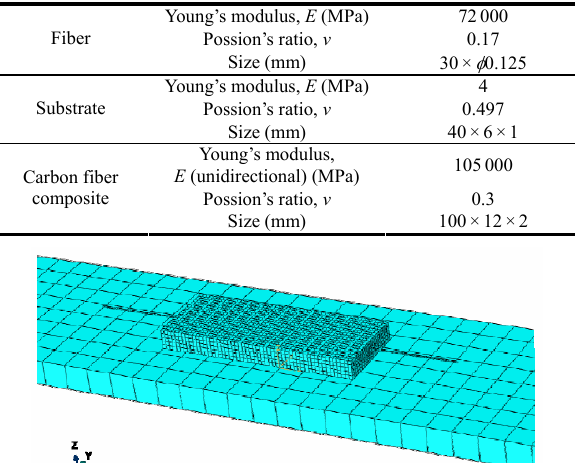
Table 1 Parameters of layers.